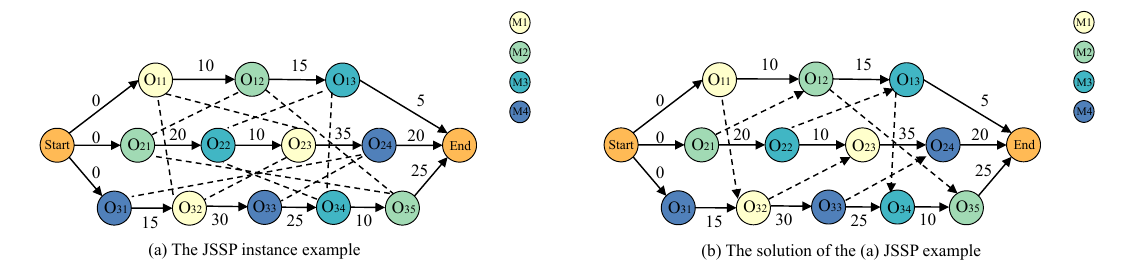
Figure 1. An example of JSSP intance and its solution representing by the disjunctive graphs. Each vertex denotes an operation of a job, and the content O ij in it denotes the j th operation of job i . The solid lines denote the conjunctive edges, while the dotted lines denote the disjunctive edges. The numbers near the edges denote the processing time needed for the operations where the edges begin. Furthermore, the vertices of the same colour mean that the operations represented by these vertices are processed on the same